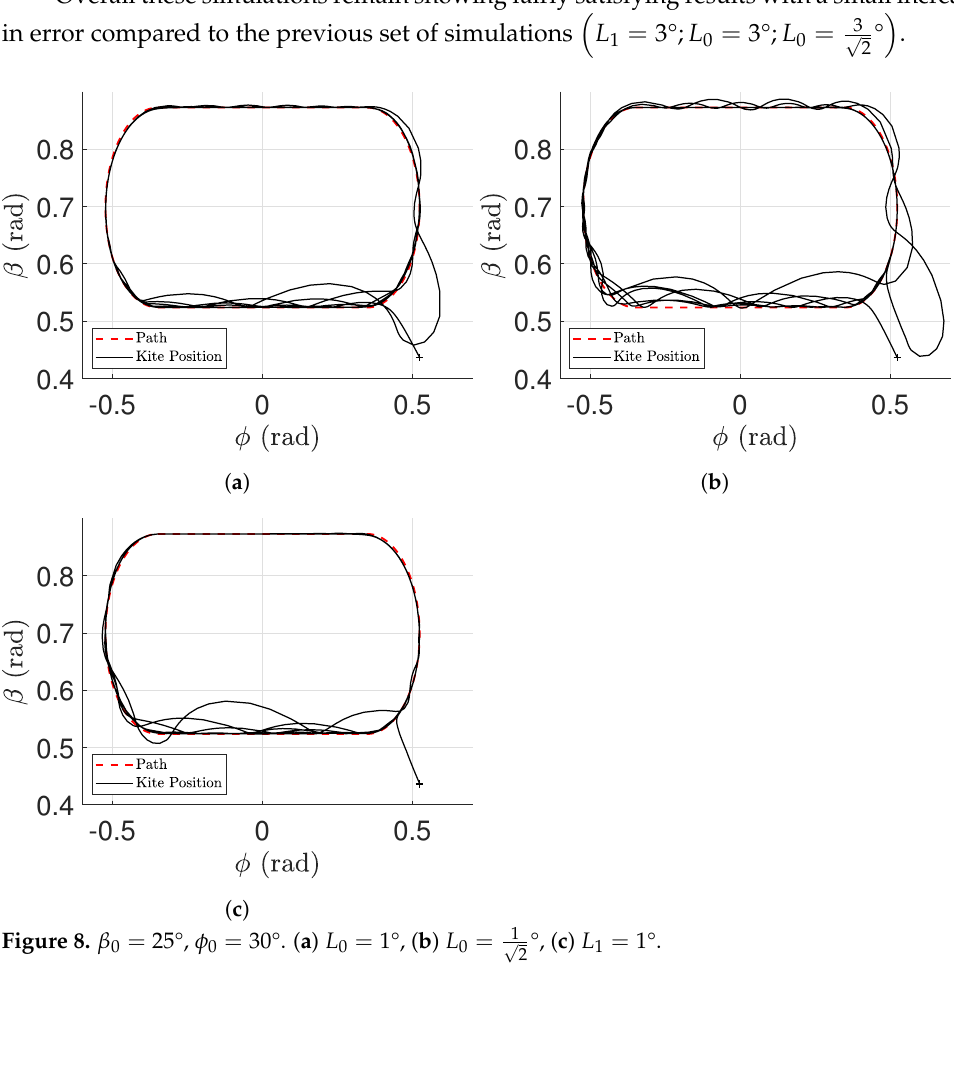
Figure 8. β 0 = 25°, φ 0 = 30°. ( a ) L 0 = 1°, ( b ) L 0 = 1 √